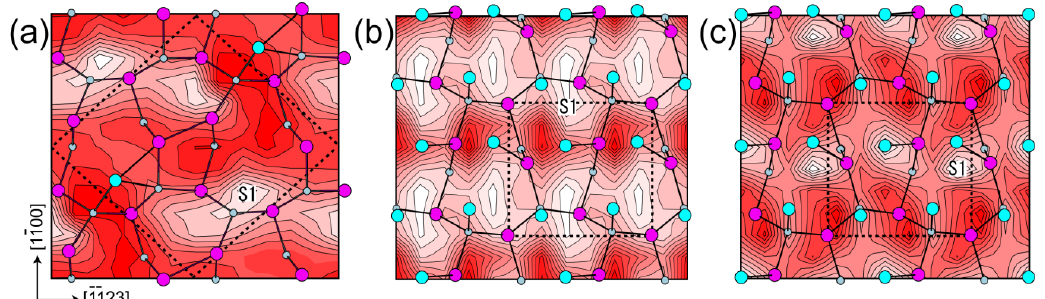
Figure 30. Contour potential energy surface (PES) plots for ( a ) an additional Ga atom on the GaN (cid:4666)112(cid:3364)2(cid:4667) surface with a Ga adatom and ( b ) Ga adatom and ( c ) N adatom on a GaN (cid:4666)112(cid:3364)2(cid:4667) surface with a Ga monolayer. Large and small circles represent Ga and N atoms, respectively. Each contour line in ( a ), ( b ), and ( c ) represents an energy step of 0.15, 0.05, and 0.15 eV, respectively. S1 represents stable adsorption sites. The dashed rectangles denote the surface unit